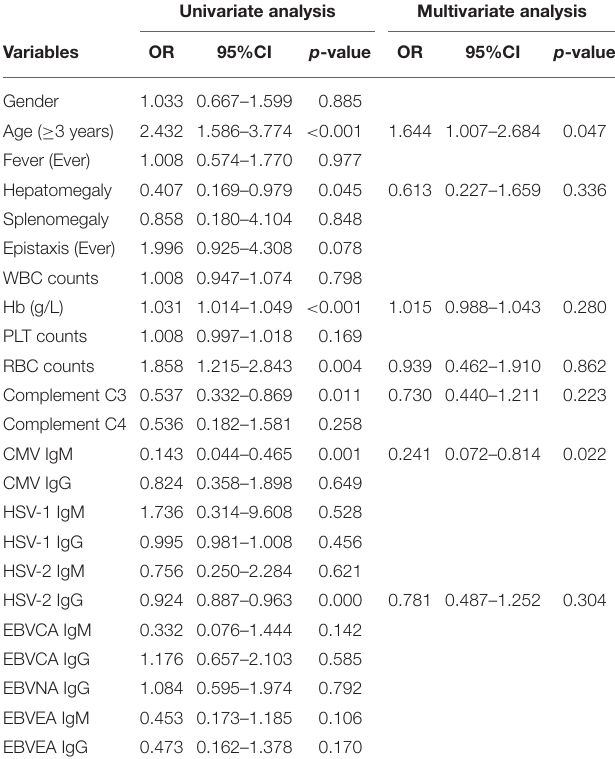
TABLE 3 | Univariate and multivariate analyses for chronic